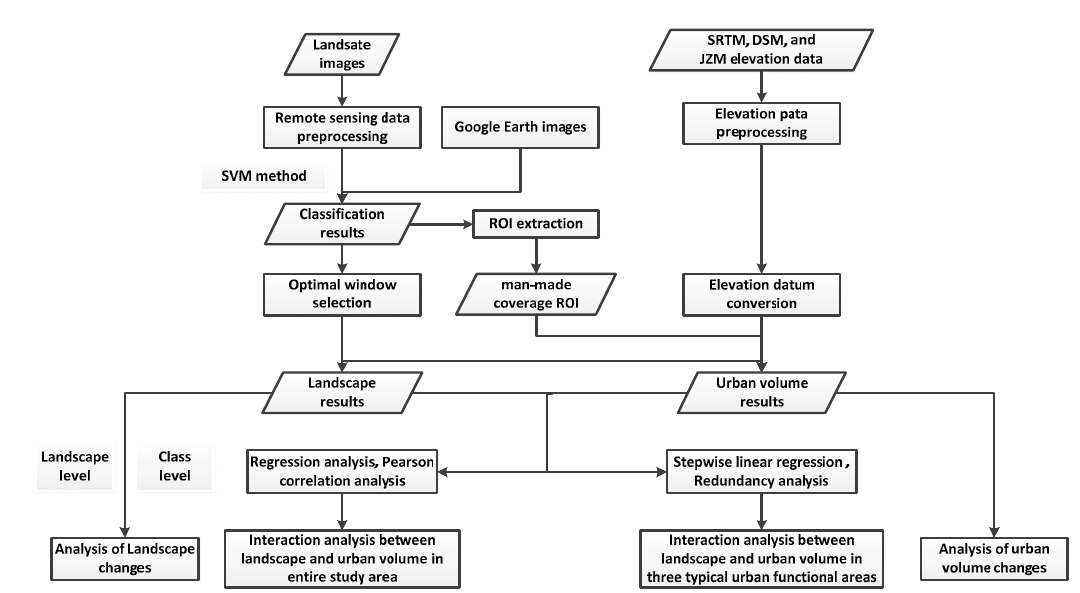
Figure 2. The flowchart of this study.